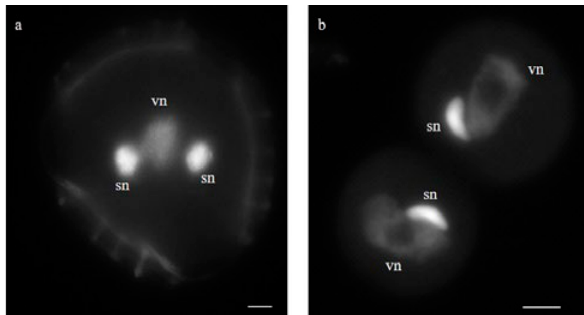
Fig. 4. Dapi staining of pollen grains. a Regular tricellular pollen grain in L. ovalifolium with one vegetative nucleus and two sperms nuclei; b Bicellular polar grain showing one vegetative nucleus (vn) and one sperm nucleus (sn). Bars = 5 µm.